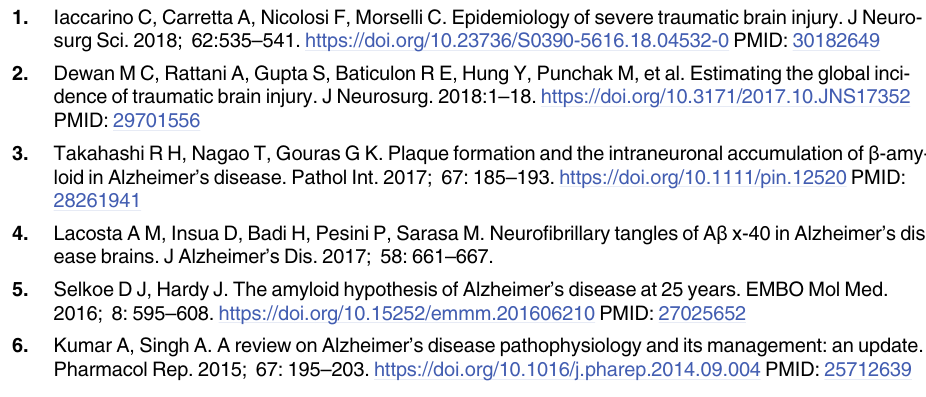
S1 Table. Characteristics of the 17 studies included in the